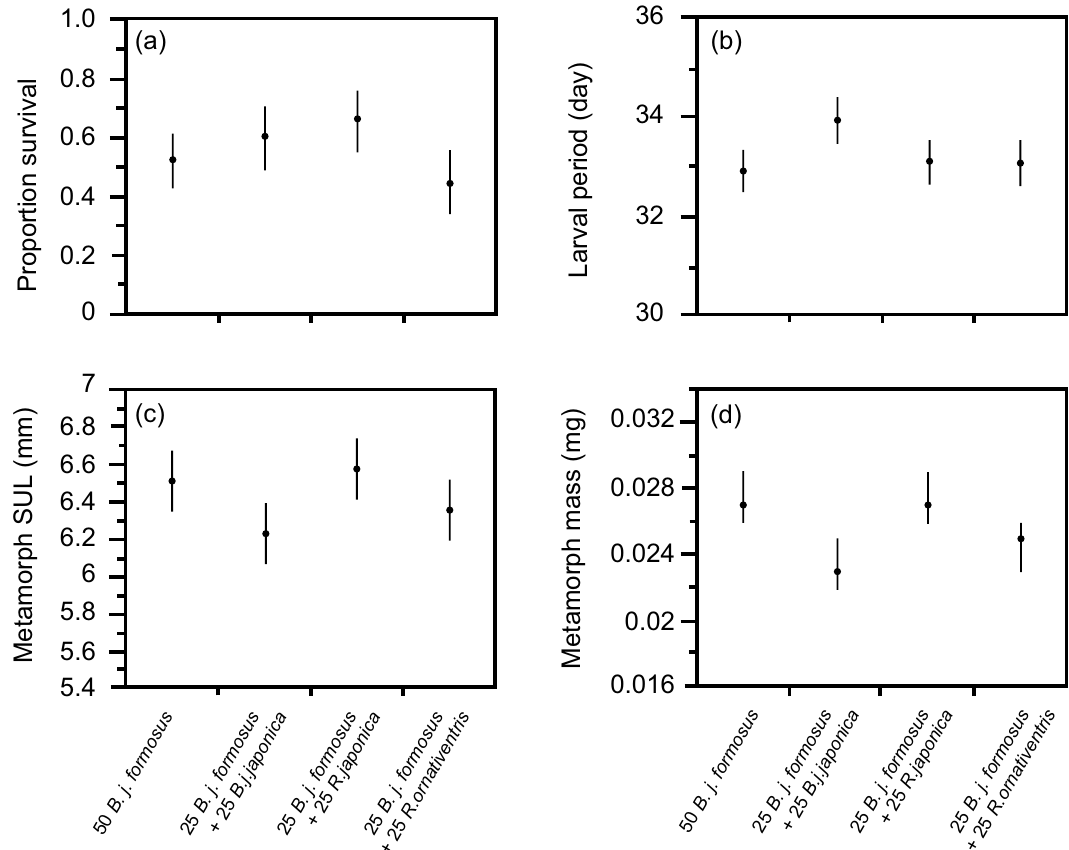
Figure 2. The effect of interspecific competition on survival, larval period and metamorph size of toads, Bufo japonicus formosus. The treatments comprised 50 B. j. formosus tadpoles, or 25 tadpoles of B. j. formosus plus 25 tadpoles of B. j. japonicus , Rana japonica or R. ornativentris . The panels show impacts on ( a ) survival rate, ( b ) larval period, ( c ) metamorph snout-urostyle length, and ( d ) metamorph mass. The graphs show mean values (based on 5 replicate containers per treatment) with standard